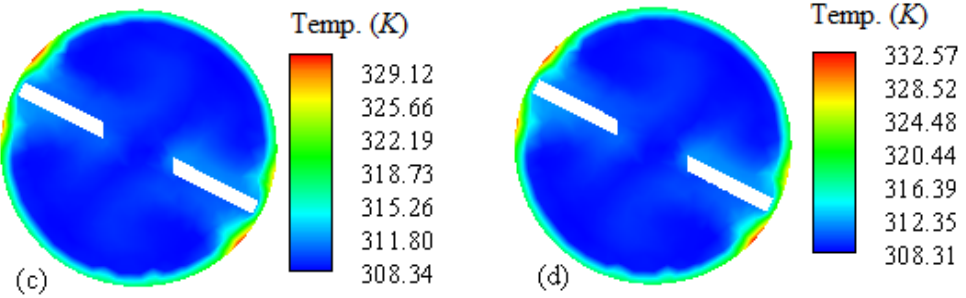
Figure 4. Temperature at axial location of 0.134 m before the flow end of the C-T tube’s cross-section for (a) 𝑹𝒆 = 𝟐, 𝟏𝟓𝟎 , (b) 𝐑𝐞 = 𝟐, 𝟑𝟎𝟎 , (c) 𝑹𝒆 = 𝟒, 𝟒𝟎𝟎 , and (d) 𝑹𝒆 = 𝟒, 𝟔𝟓𝟎